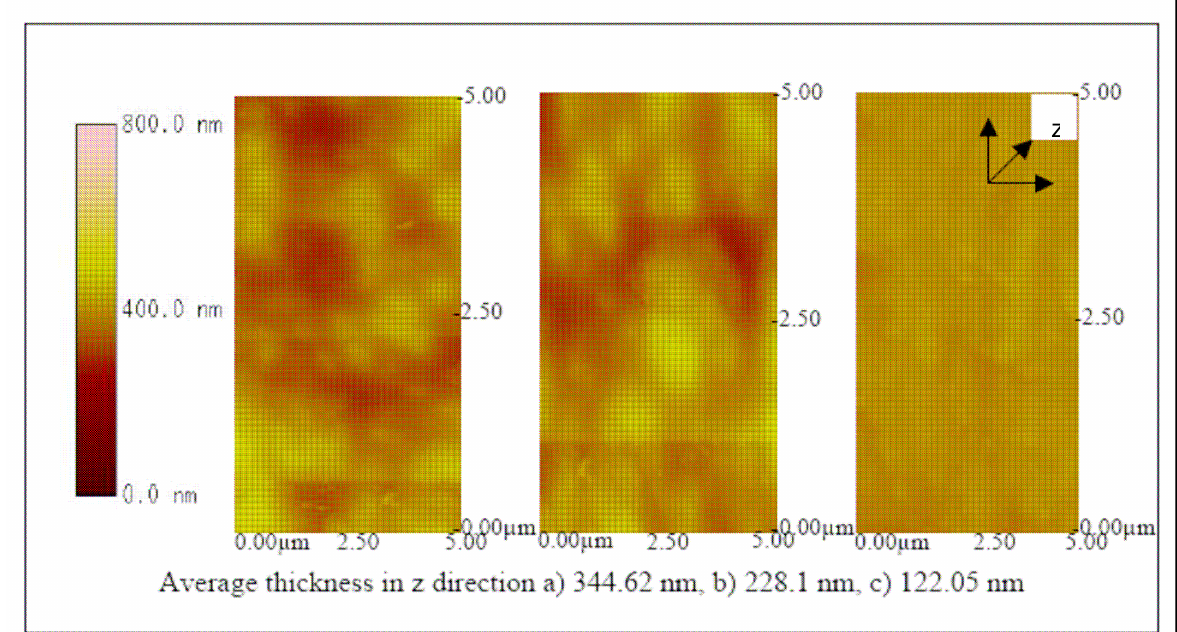
Figure 11. Atomic force microscopy images of a) ITO glass spin coated with Pani (65KDa) +